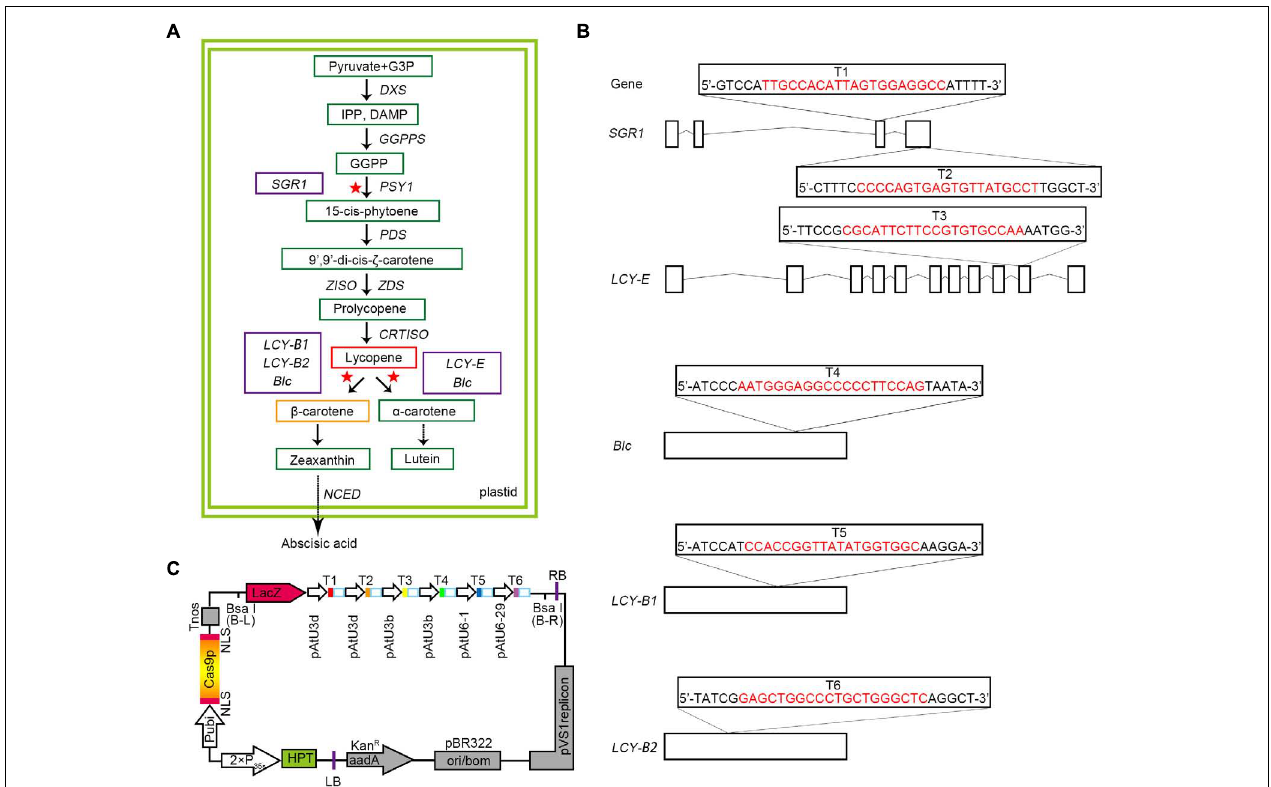
FIGURE 1 | Selection of target genes and designing of CRISPR/Cas9 binary expression cassette. (A) A map of the target genes in the carotenoid metabolic pathway. The green boxes represent the key substances in the metabolic pathway. The red and orange boxes show the two substances, lycopene and β -carotene, respectively. A solid arrow indicates a direct effect, and a dashed arrow indicates an indirect effect. The selected target genes are represented by purple boxes, and the red asterisks represent the sites at which the target genes act on the pathway. G3P, glyceraldehyde 3-phosphate; DXS, 1-deoxy- D -xylulose 5-phosphate synthase; GGPPS, geranylgeranyl pyrophosphate synthase; PDS, phytoene desaturase; ZISO, z-carotene isomerase. (B) Five target genes were selected according to the synthesis and metabolism pathways of lycopene, and six target sites were designed. The target sequences are marked in red, and small rectangle frames indicate the PAM. Straight lines and boxes are the introns and exons of the target genes, respectively. (C) Structures of the pYLCRISPR/Cas9-Lycopene binary vectors. HPT( − H) encodes hygromycin B phosphotransferase. The six targets designed are represented by solid boxes in different colors, and the promoters used for each target are